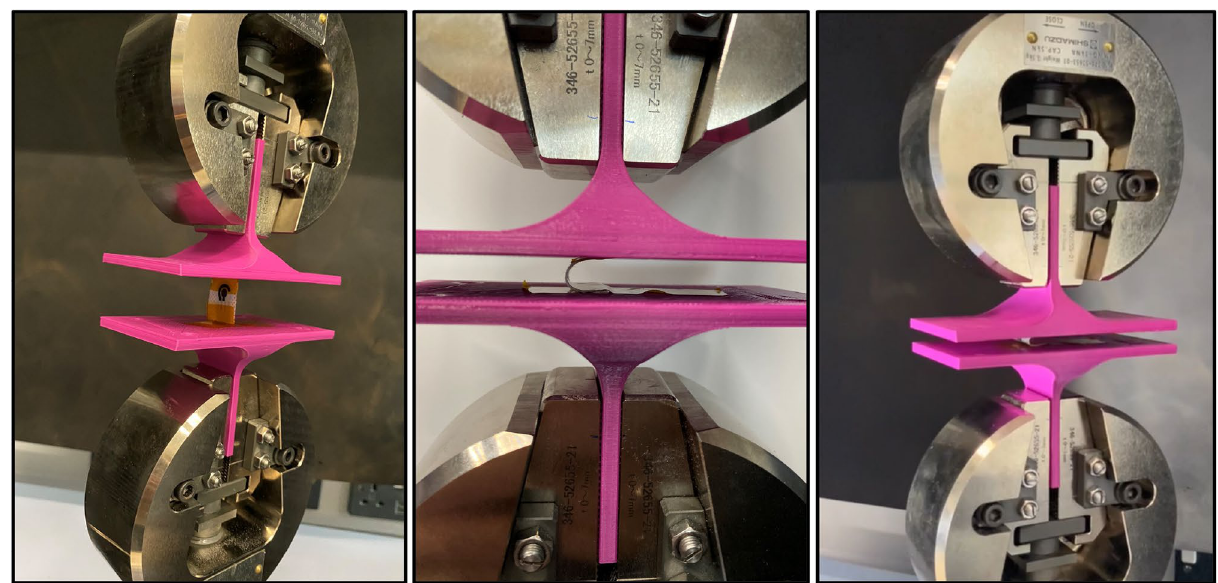
Figure 7. Shimadzu mechanical bending setup with bespoke attachments.